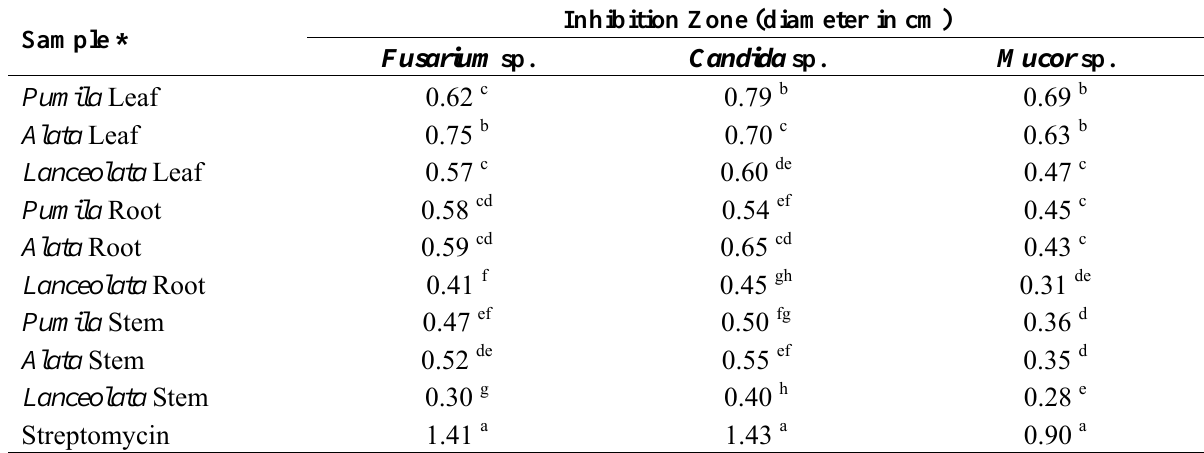
Table 5. Inhibition zones of leaf, stem and root extracts of three varieties of Labisia pumila against pathogenic fungi at concentration of 500